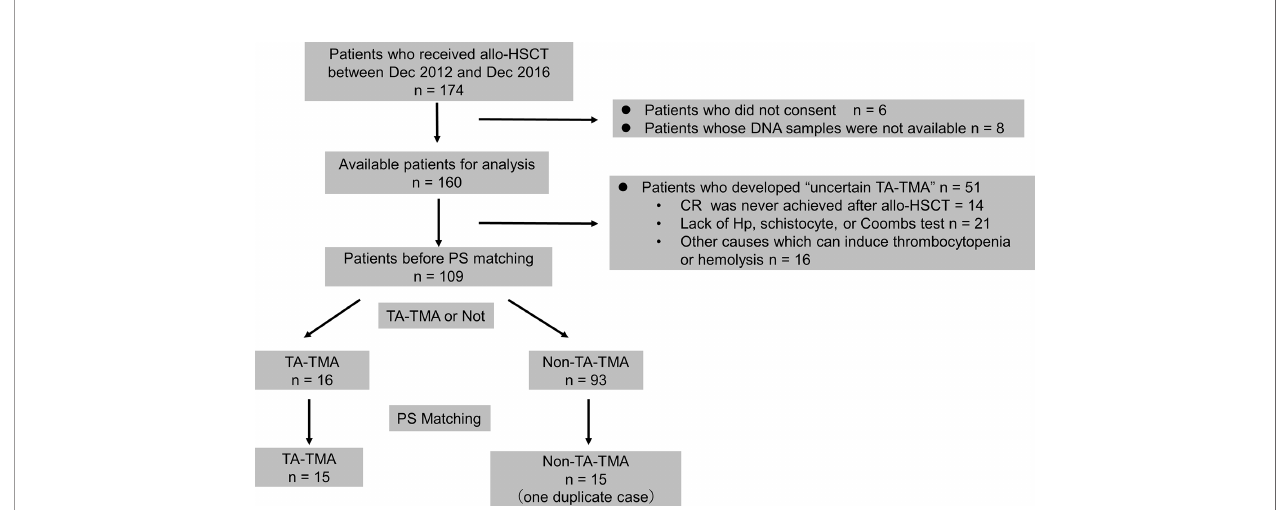
FIGURE 1 | Flowchart for patient selection. allo-HSCT, allogeneic hematopoietic stem cell transplantation; CR, complete response; Hp, haptoglobin; PS, propensity score; TA-TMA, transplant-associated thrombotic